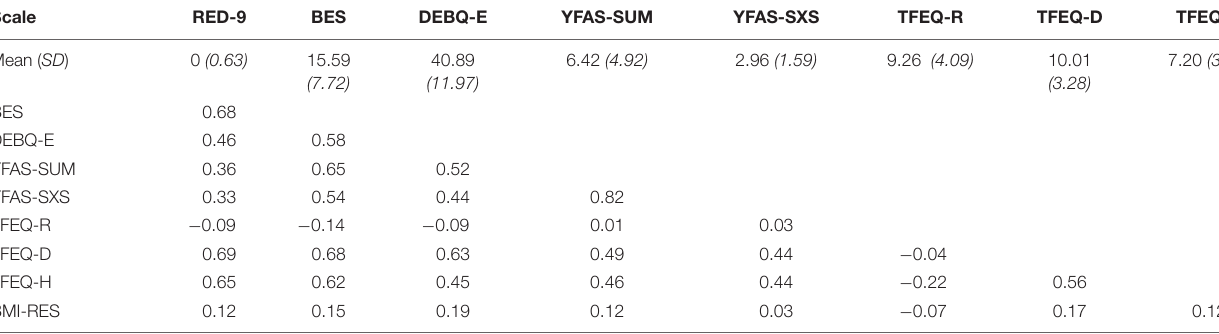
TABLE 2 | Correlations among the RED-9 and other scales in Study